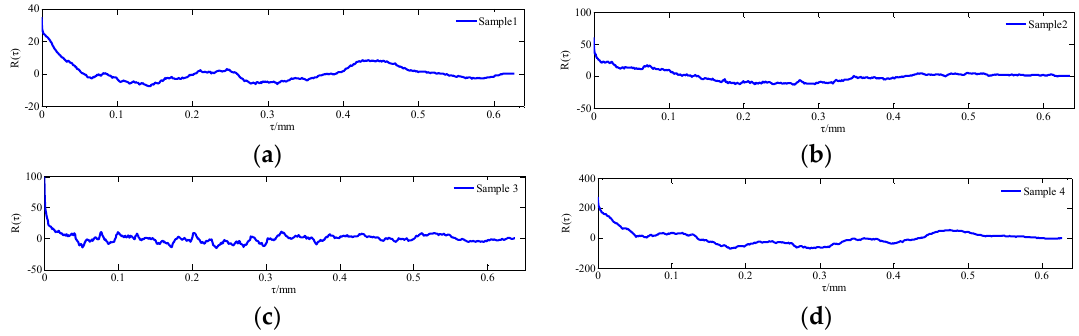
Figure 9. Autocorrelation graphs for different surface morphologies ( a ) The upper surface of the specimen 1; ( b ) The lower surface of the specimen 2; ( c ) The upper surface of the specimen 3 and ( d ) The lower surface of the specimen 4.